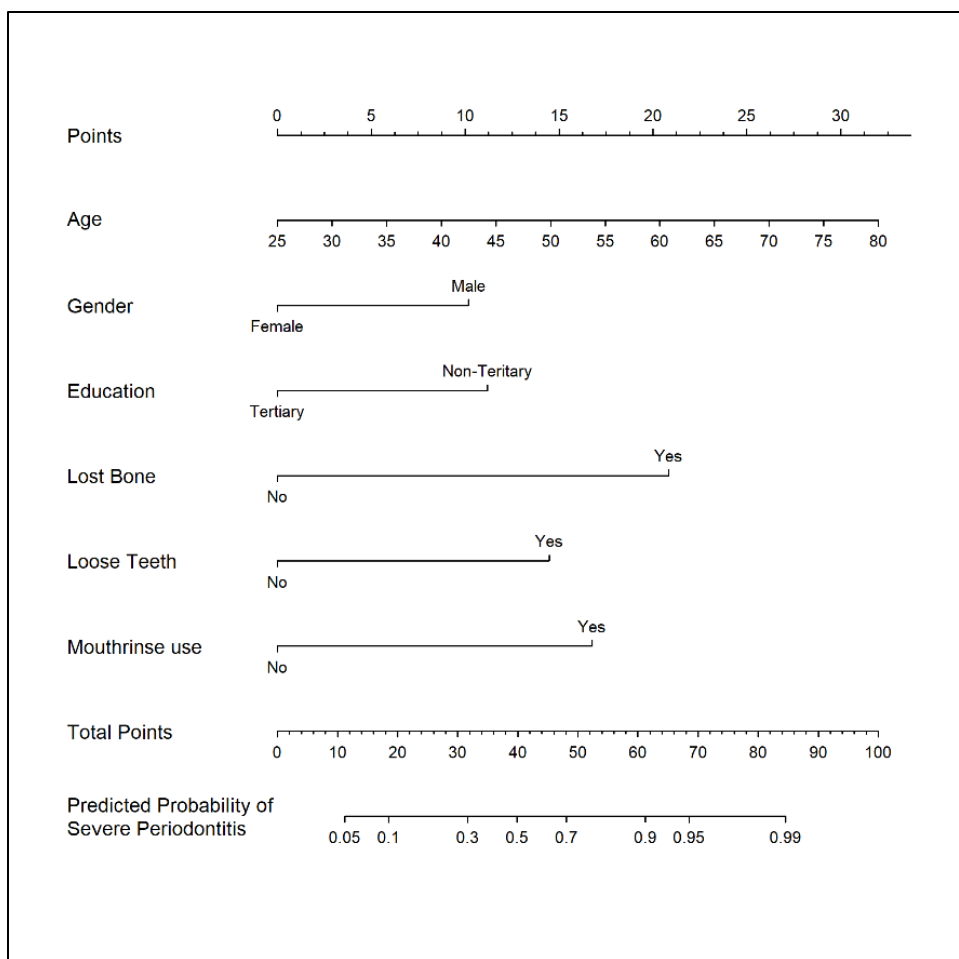
Figure 2. Nomogram to predict severe periodontitis according to WWC classification. To use the nomogram, an individual participant’s value is located on each variable axis, and a line is drawn upward to determine the number of points received for each variable value. The sum of these numbers is located on the Total Points axis to determine the risk of severe periodontitis. (WWC: World Workshop on the Classification of Periodontal and Peri-Implant Diseases and Conditions).